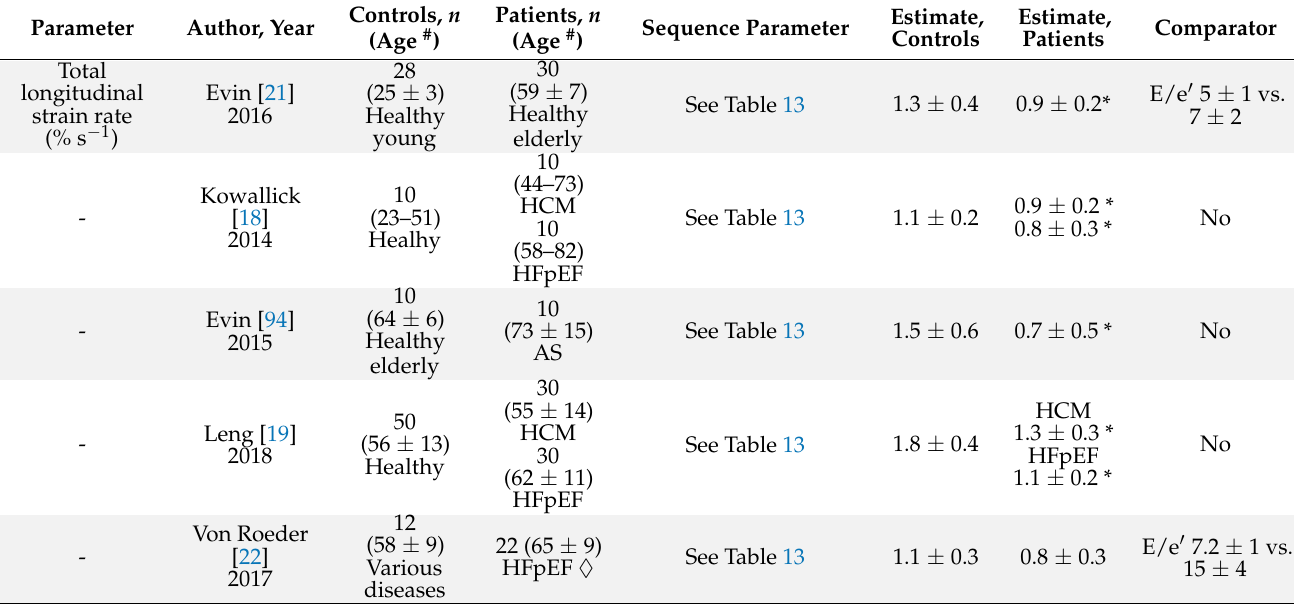
Table 14. LA feature tracking—total longitudinal strain